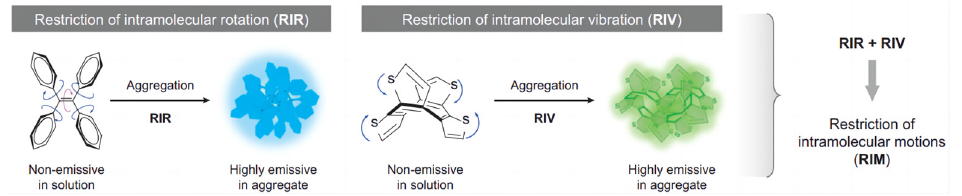
Figure 1. Tetraphenylethene (TPE) is non ‐ emissive when dissolved but becomes emissive when aggregated due to the restriction of intramolecular rotation (RIR), restriction of intramolecular vibration (RIV), and restriction of intramolecular motion (RIM). Adapted with permission from [2].